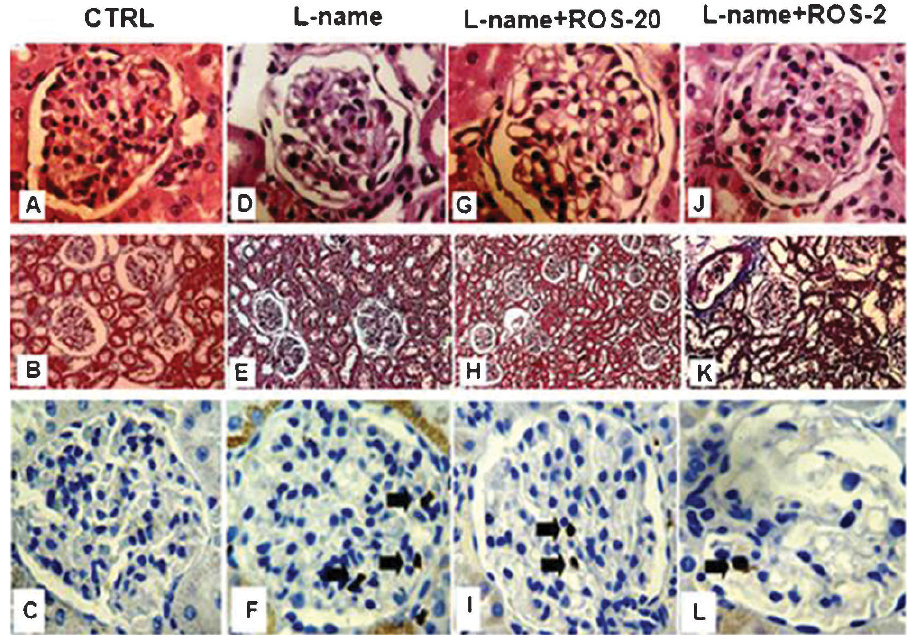
Figure 3 - Histological and immunohistochemical analysis. Representative glomerular sections stained with hematoxylin/eosin (A,D,G,J; 400 6 ), cortical sections stained with Masson’s trichrome (B,E,H,K; 20 6 ) and immunohistochemical analyses of glomerular macrophages (C,F,I,L) in each group of rats ( n =10/group). These analyses did not detect changes in the glomerular, vascular, tubular or interstitial compartments. Glomerular macrophages were most abundant in the L-name group (arrow).